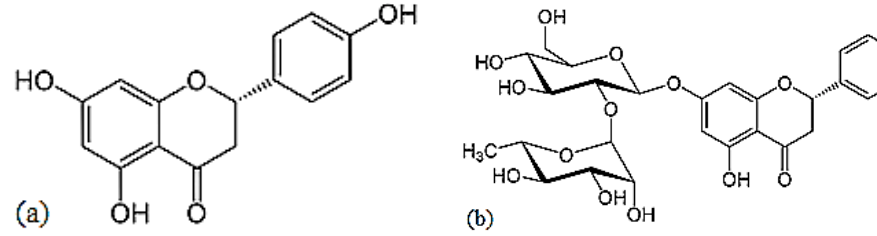
Figure 9. Structures of naringenin ( a ) and naringin ( b ).